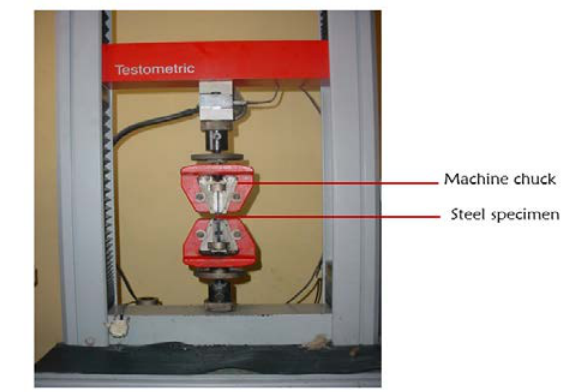
Figure 1: Muffle furnace Figure 2: Arrangement of the specimen on the machine chuck